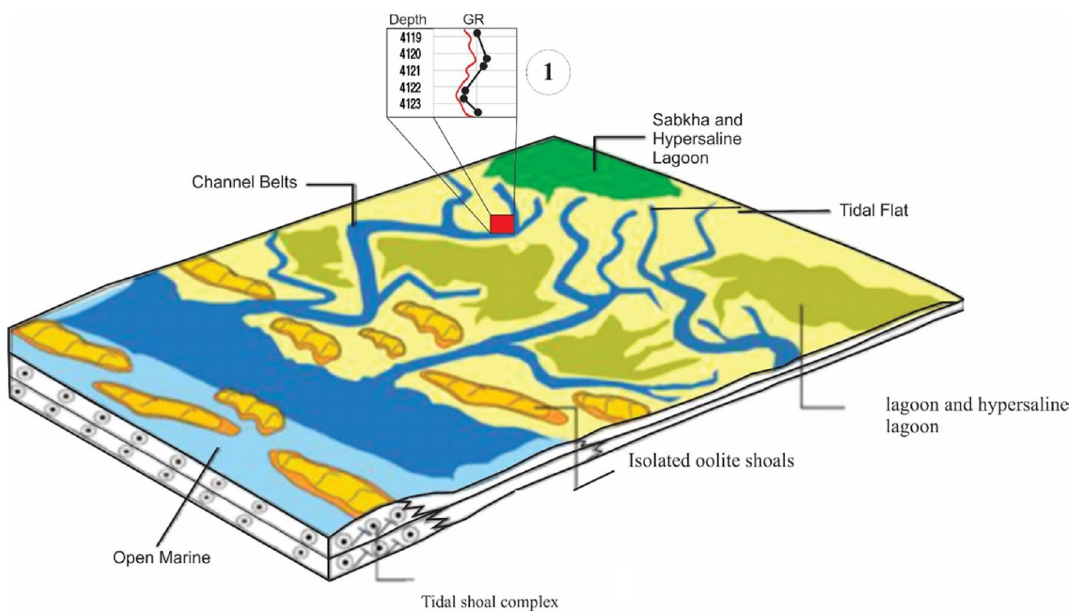
Fig. 22 Depositional model for electrofacies 1 of the Lockhart Limestone of Meyal-10P. The log trends are from GR